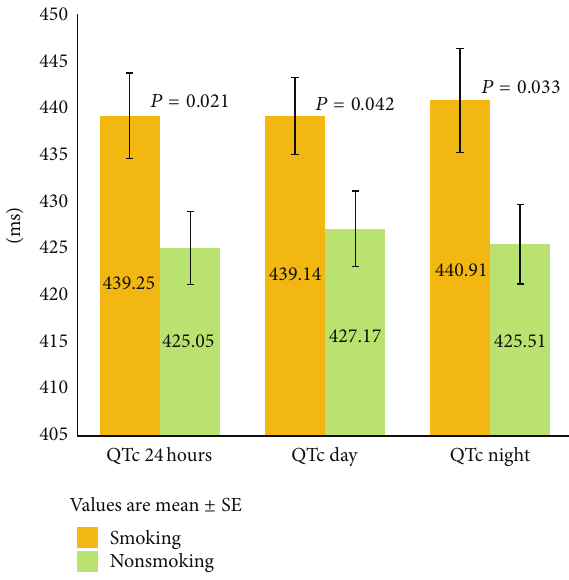
Figure 1: Results of mean QTc interval during the 24-hour, day, and night period in relation to smoking